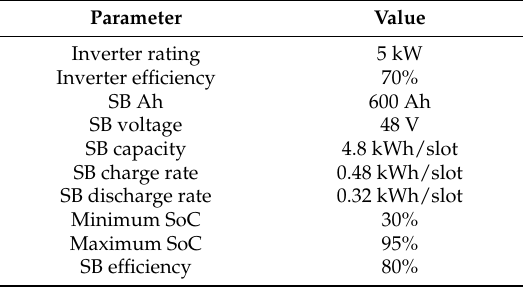
Table 8. SB and inverter